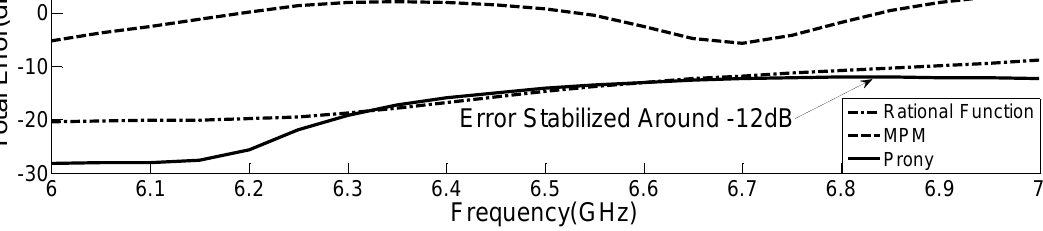
− 12 dB. In the meantime, in the case of MPM, its error tends to exceed –5 dB.